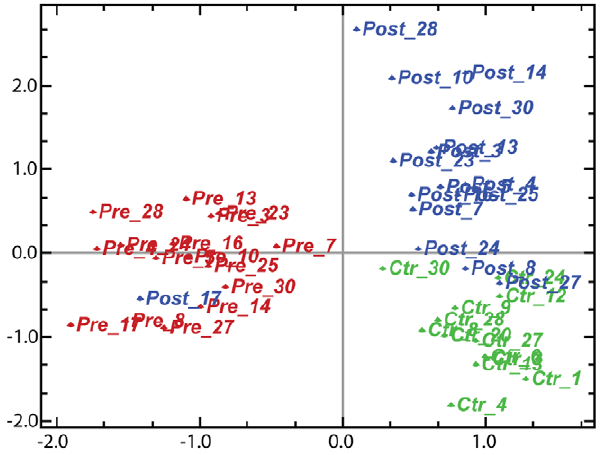
Figure 1. Correspondence Analysis showing projection of samples before and after bariatric surgery and lean healthy controls. The first principal component (10.69% component variance) separated the pre-operative samples from the post-operative and control samples, and the second principal component (6.36% component variance) separated the post-operative from control samples. The post-operative sample of patient 17 was similar to the pre-operative samples, suggesting an overall unaltered gene expression pattern after surgery for this patient. A technical error may have occurred, but we cannot rule out a unique gene expression pattern in the adipose tissue of this patient.